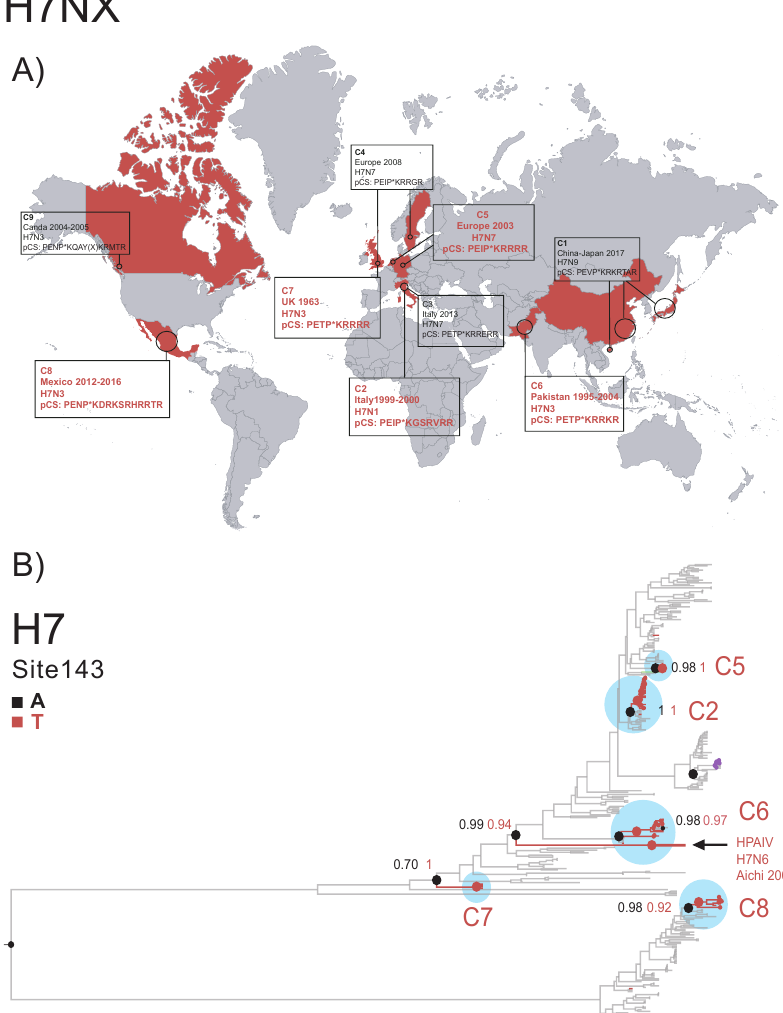
Figure 8. ( A ) Geographical occurrence of historic Highly-Pathogenic (HP) outbreaks for the H7NX viruses. Countries of emergence are highlighted in red. Year of circulation, virus subtype and consensus sequence for the polybasic Cleavage Site (pCS) within the Hemagglutinin (HA) protein are indicated for the selected outbreaks used in this work (C1-C9). Each outbreak corresponds to a distinct genotype, defined as well- supported clusters within all viral genome segment trees (data not shown). ( B ) MCCtree for the HA protein with reconstruction of ancestral states for site 143, as mutation A143T was found to be evolving under parallel evolution and to be associated with the HP phenotype, occurring in 4/9 of the HP clusters analysed. This mutation is a non-conservative amino acid change located within an antigenic pocket site. Branches within the trees are coloured according to the corresponding amino acid states in nodes (tip states not shown). Ancestral nodes preceding the emergence of a mutation associated with the HP lineages are represented with coloured circles. The probabilities of a given amino acid state occurring within ancestral/descending nodes are indicated. The HP clusters of interest are highlighted with blue circles. Mutations strongly associated with an HP phenotype may function as an early detection system for transitional virulence